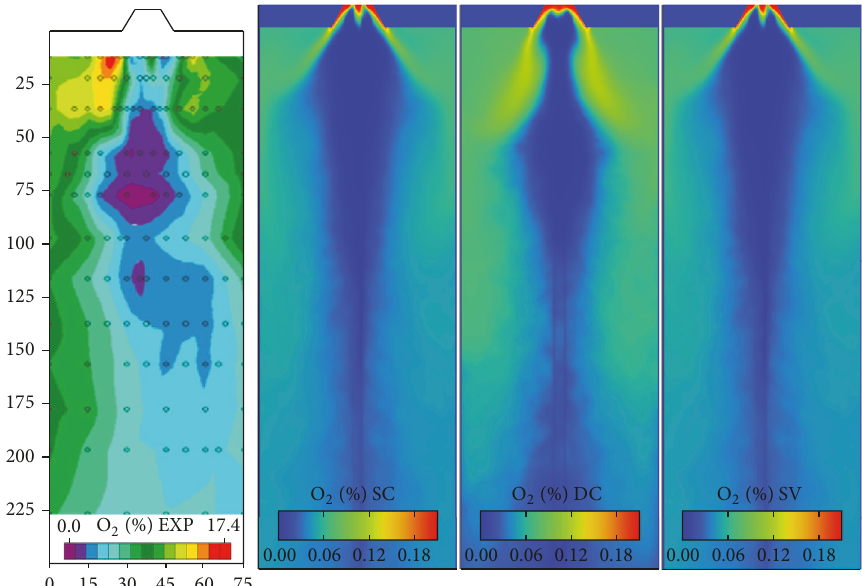
Figure 11: Experimental (adapted from [5]) and numerical maps of O 2 concentration. Dimensions on the the left are given in